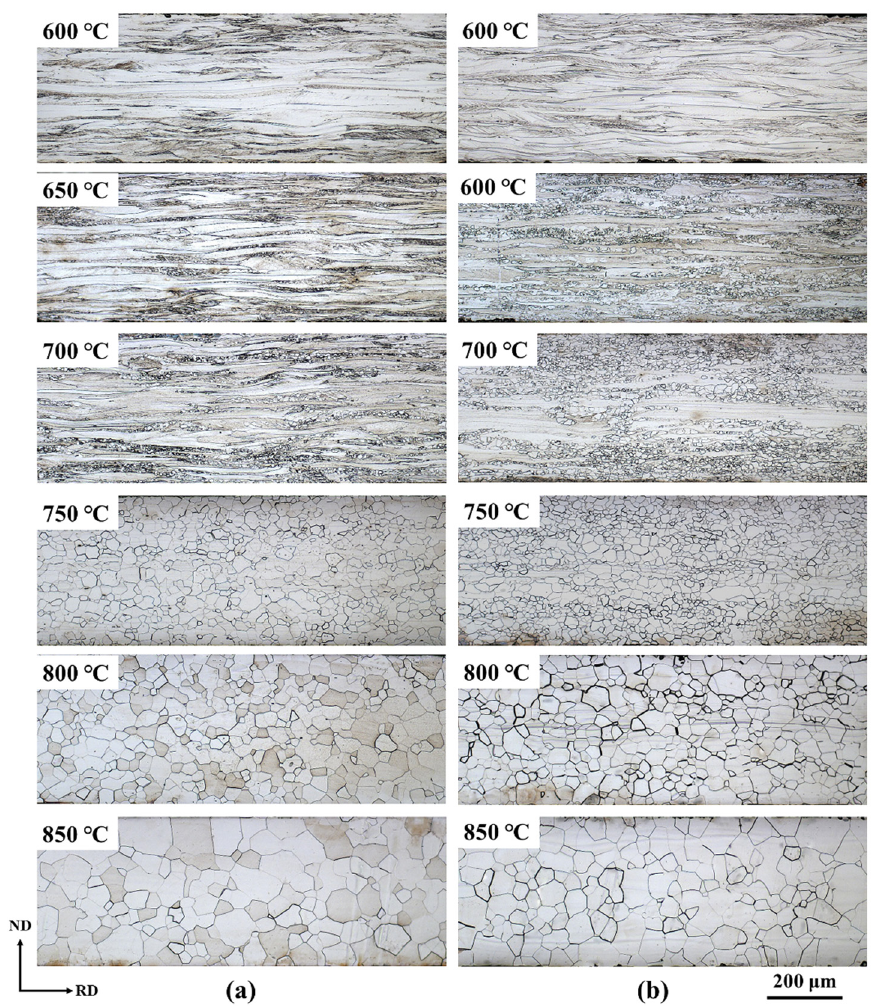
Figure 3. Optical microstructure of samples annealed at different annealing temperatures. ( a ) Symmetric rolling (SR); ( b ) ASR.